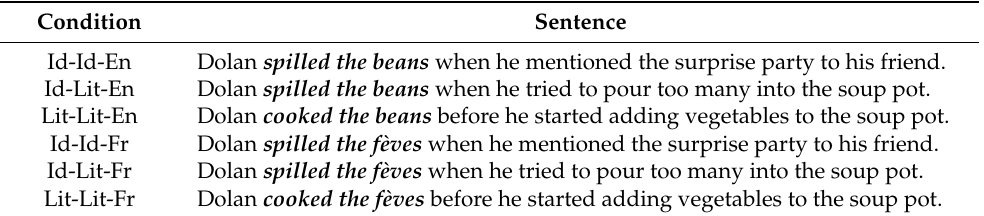
Table 6. Example sentences of Idiomatic–Idiomatic (Id-Id), Idiomatic–Literal (Id-Lit), and Literal– Literal (Lit-Lit) conditions, both intact (En) and switched (Fr), from Experiment 2.